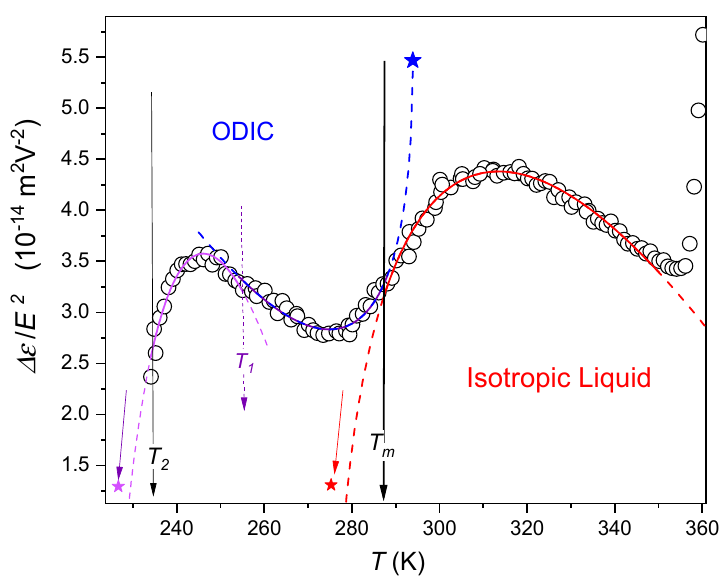
Figure 5. The temperature dependence of nonlinear dielectric effect (NDE) in the liquid and ODIC phases of cyclooctanol. Solid curves are related to Equation (7) with T m = 287.5 K ( T * = 276 K), T 1 = 254.5 K ( T * = 293.8), T 2 = 234 K ( T * = 220 K). Fitting parameters are given in Table 1.